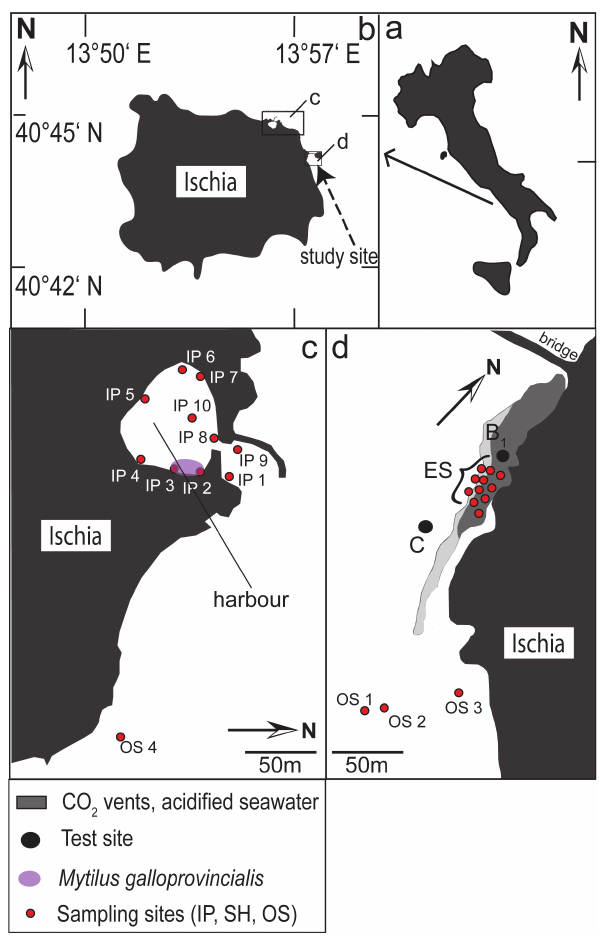
Fig. 2. Map of Italy (a) and the Island of Ischia (b) . (c) Schematic map of Ischia harbour with location of the seawater sampling points IP (Ischia Port) and OS (oceanic seawater), as well the location of M. galloprovincialis , marked by the purple dot. (d) Schematic map of the natural experiment sites off Ischia in the vicinity of CO 2 vents. Specimens of M. galloprovincialis were transplanted in September 2009 from the harbour (pH 8.07) to control site C (mean pH T 8.07) and experimental site B1 (mean pH T of 7.25, minimum pH T 6.83) where they were kept until December 2009 (modified af- ter Hall-Spencer et al., 2008). Seawater sampling sites are labelled OS and